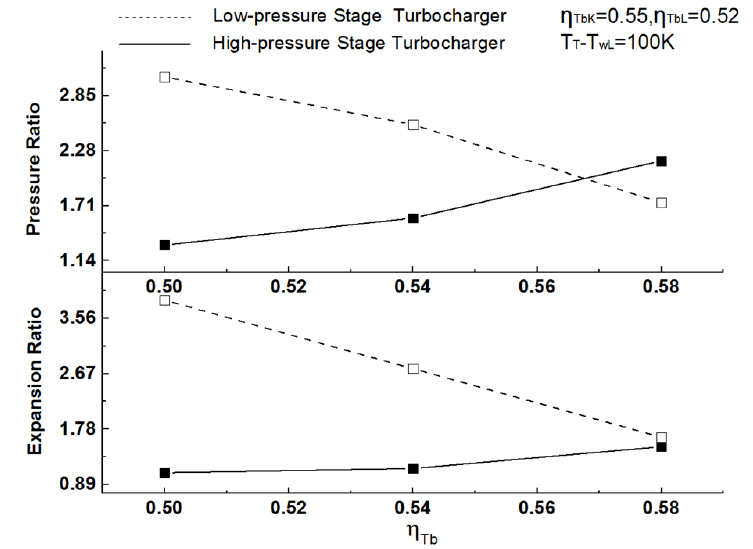
Figure 3. Relationship between the total turbocharger e ffi ciency and the Pressure Ratio / Expansion Ratio.